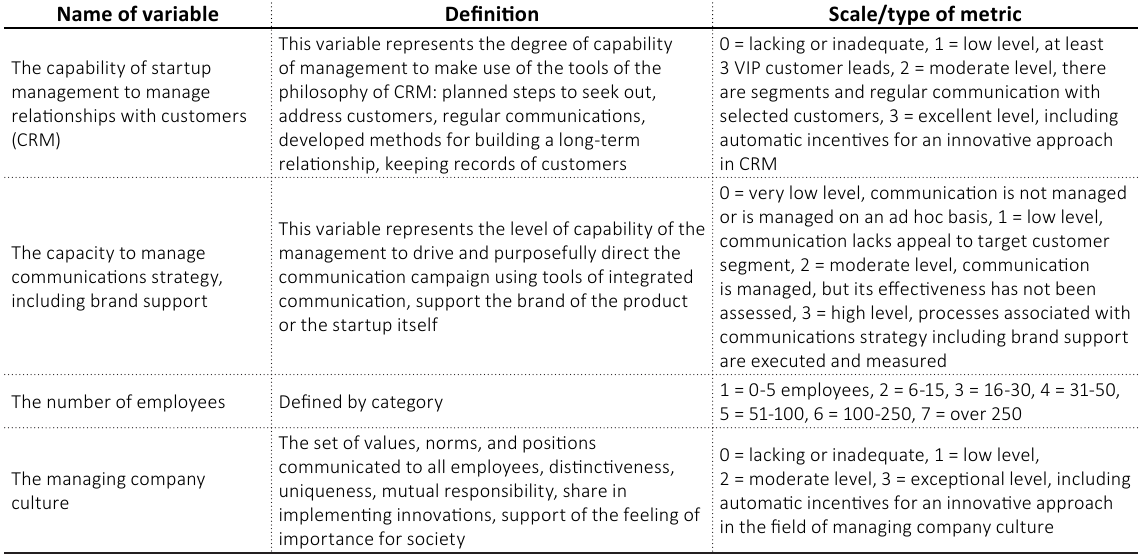
Table 1 (cont.). Description of variables